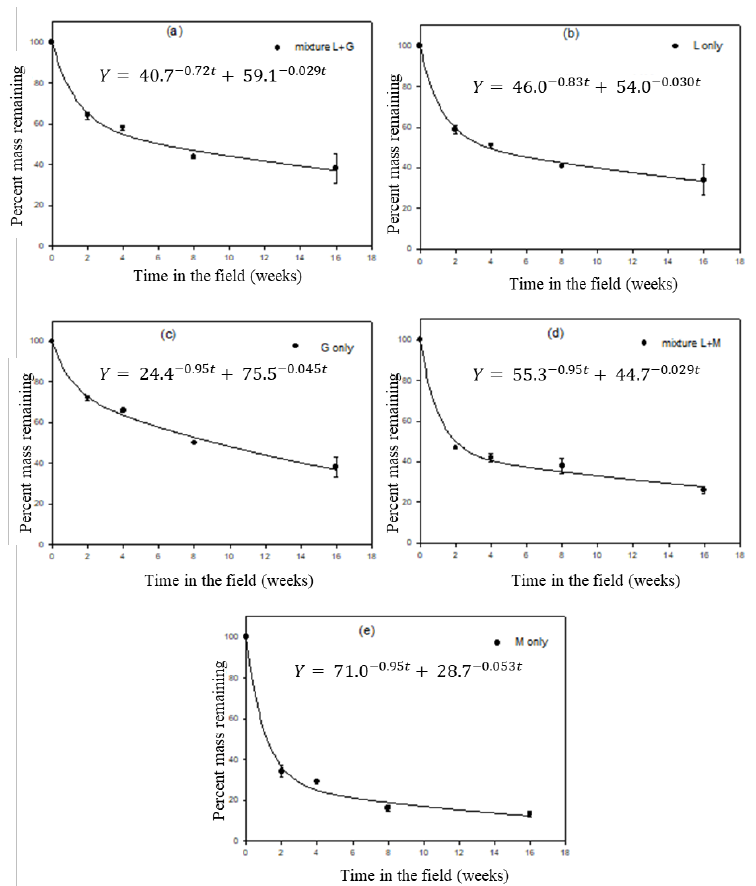
Figure 5. Modeled and measured mass remaining from decomposing leaves (( a ) = Leucaena + Guazuma , ( b ) = Leucaena , ( c ) = Guazuma , ( d ) = Leucaena + Moringa , ( e ) = Moringa ) for the wet period. Bars are SE. Table 3. Correlation coefficients (r) among decomposition parameters and leaf chemical quality for the dry and wet